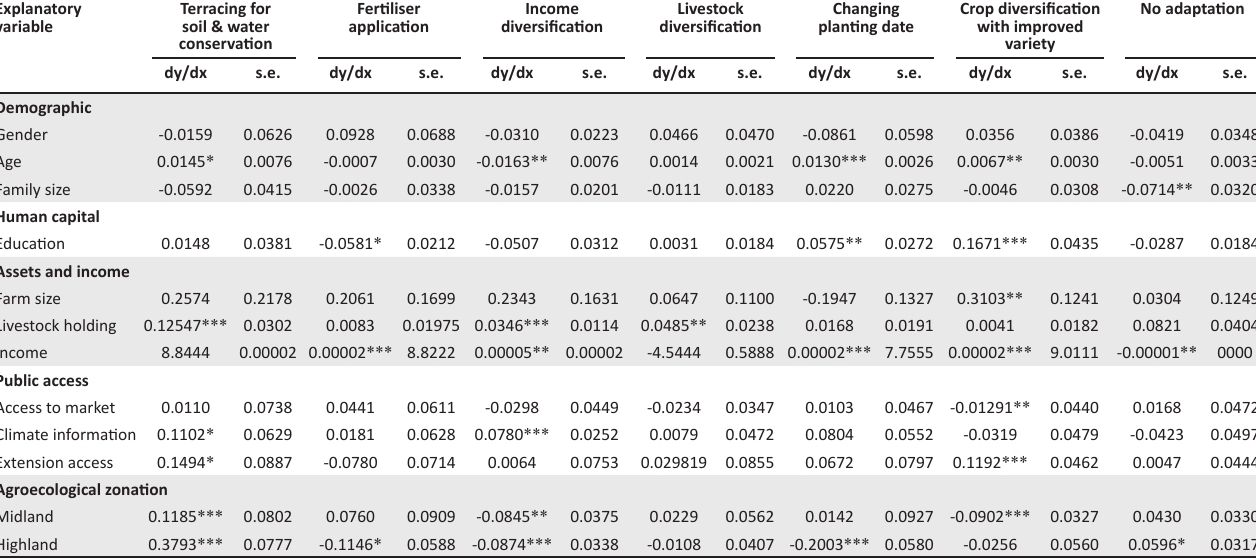
TABLE 3 : Marginal effects from the multinomial logit climate change adaptation model. Explanatory